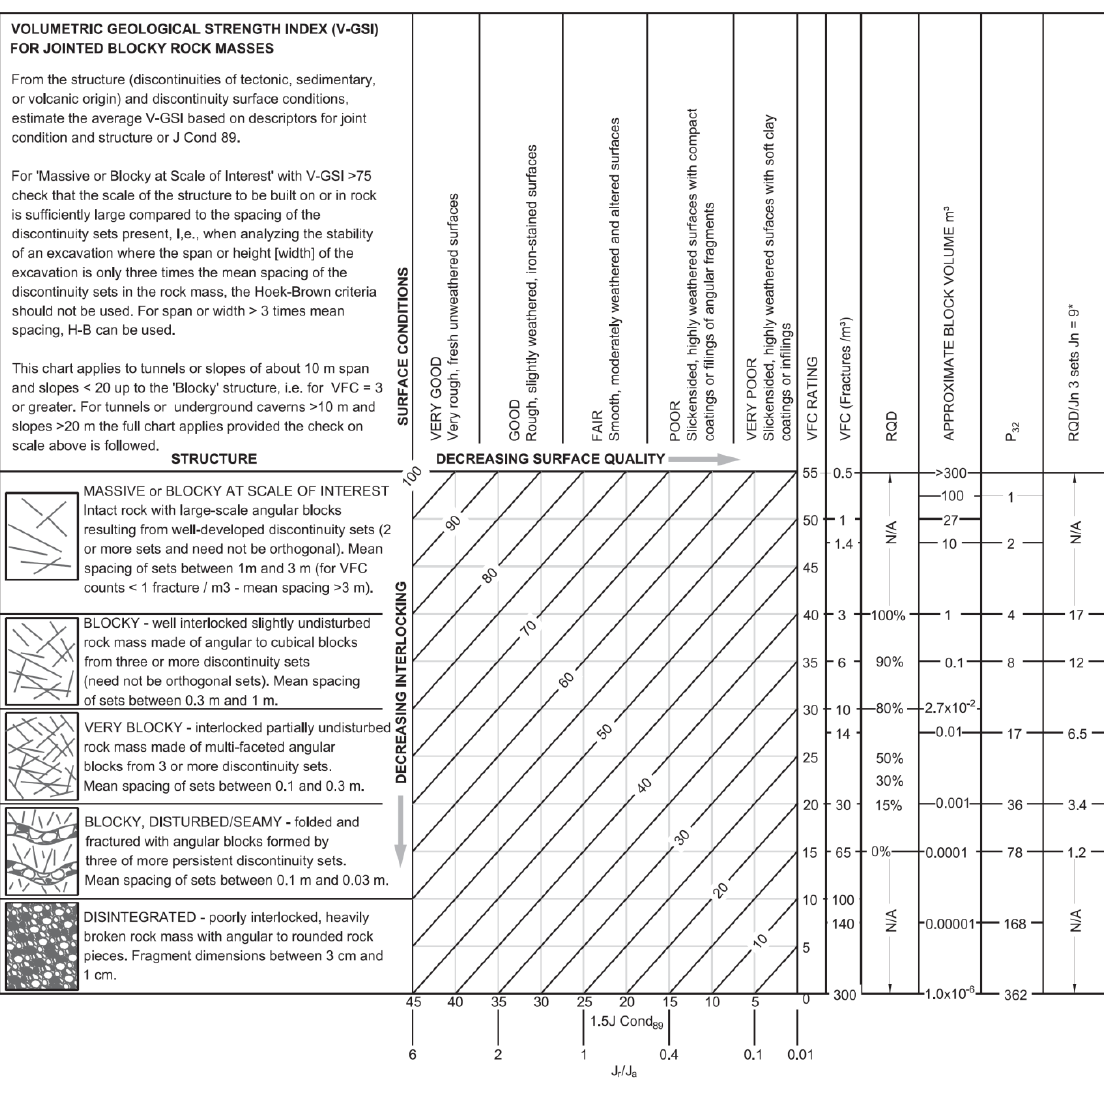
Figure A16. Quantified GSI chart [41].